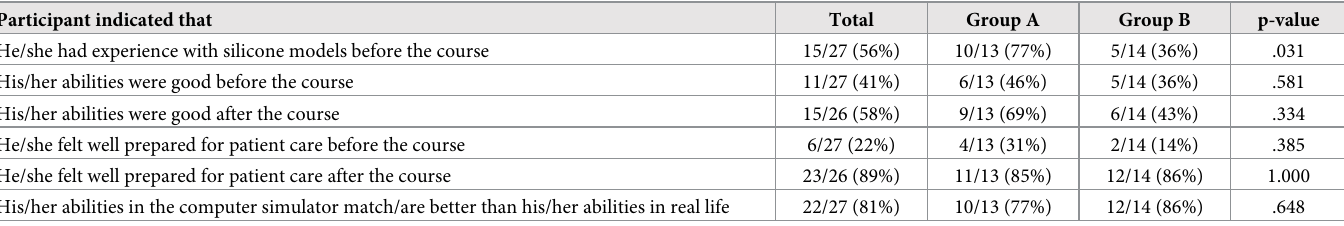
Table 1. Illustration of the statistical evaluation of the received questionnaires. Participant indicated that